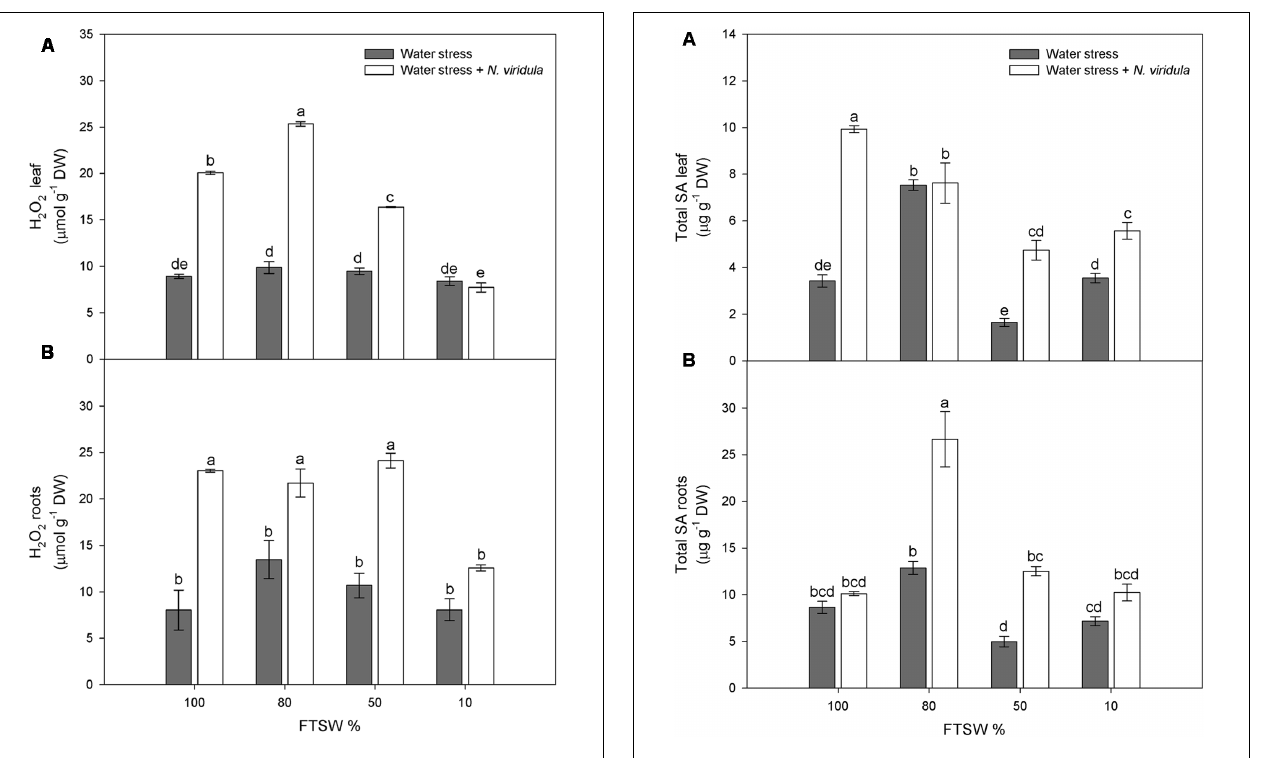
FIGURE 5 | Quantitative measurements ( µ g g − 1 DW) of total SA in well-watered and water-stressed broad bean plants with or without N. viridula infestation. Total salicylic acid (SA) contents in leaves (A) and roots (B) of V. faba plants under developing water stress (gray bars) and with an associated presence of N. viridula infestation (white bars). Measurements were made at 100, 80, 50, and 10% of FTSW. Data are means ± SE ( n = 8). Different letters indicate significant differences ( P <